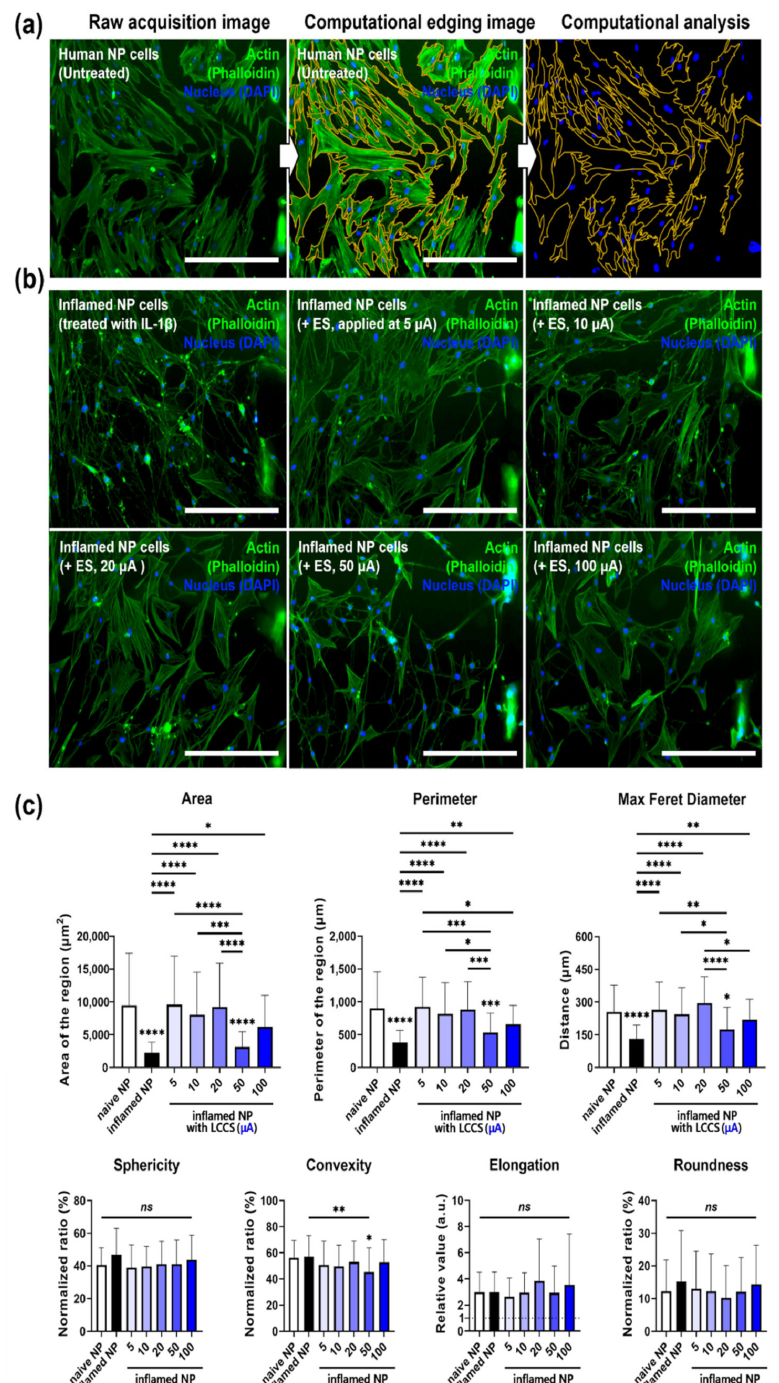
Figure 5. LCCS has a regenerative effect on IL-1 β -mediated inflamed human NP cells in the LCCS platform. ( a ) For kinetic analysis, computational edging processing methods were performed from raw acquisition images using imaging software. ( b ) Immunofluorescence image and ( c ) quantitative kinetic measurement of morphological changes in human NP cells, exposed to IL-1 β with/without ES in the LCCS platform. Each value is the mean ± standard error of five independent experiments. Scale bar = 400 µ m. Ns , no significant difference. * p < 0.05, ** p < 0.01, *** p < 0.001, **** p < 0.0001 as compared with naïve NP. The line indicates a comparison with each